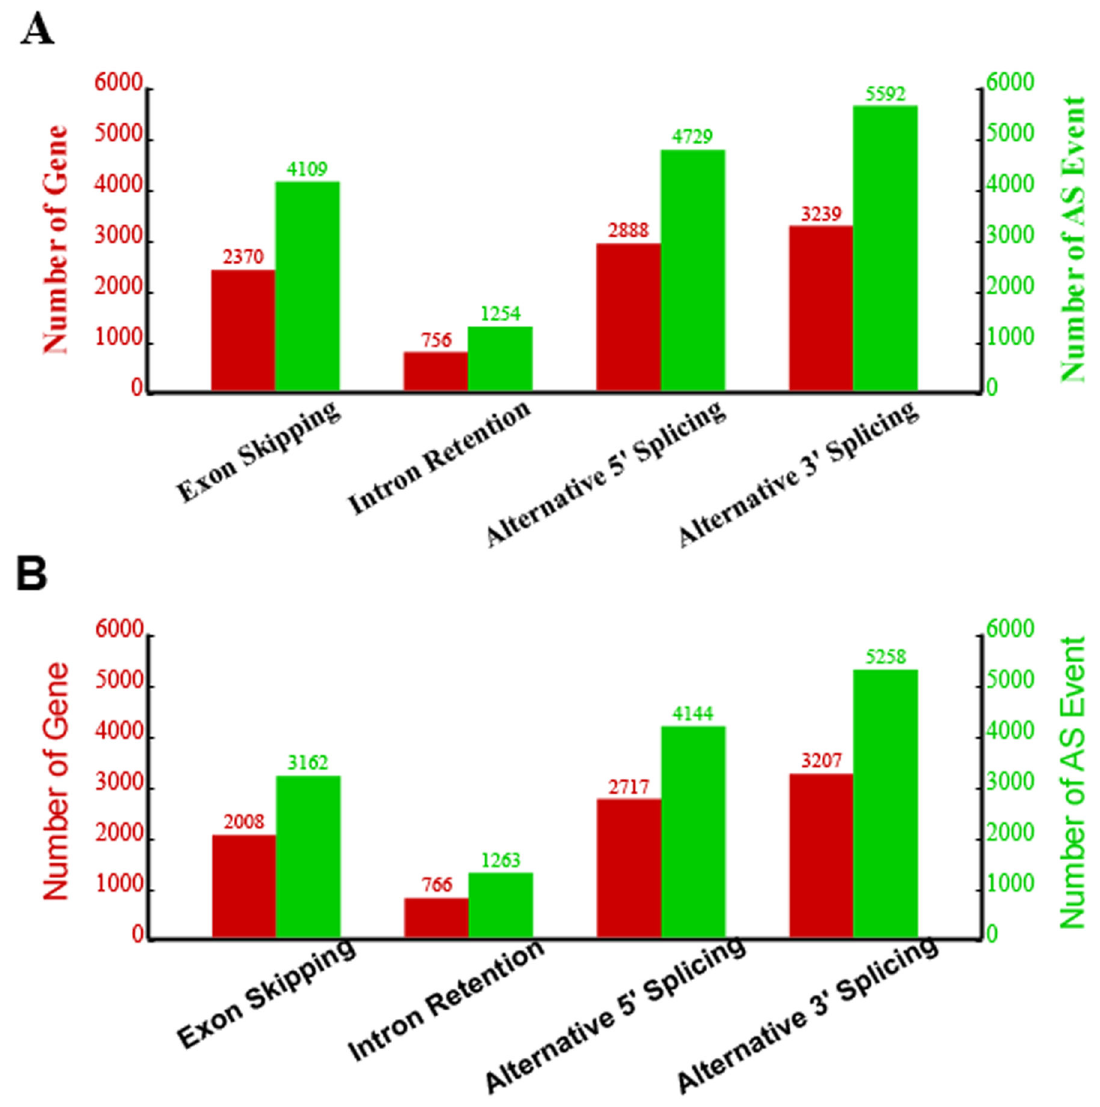
Figure 7. Alternative splicing events and genes detected between the two samples. This diagram depicts the number of AS events, including all four event types in the two samples. (A) shows AS in the DP and (B) shows the same for the SH. The red bars and coordinates represent reference genes subject to AS. The green bars and coordinates show the number of every AS type. A3SS (alternative 3’ splicing) was the principal type of AS found, followed by A5SS (alternative 5’